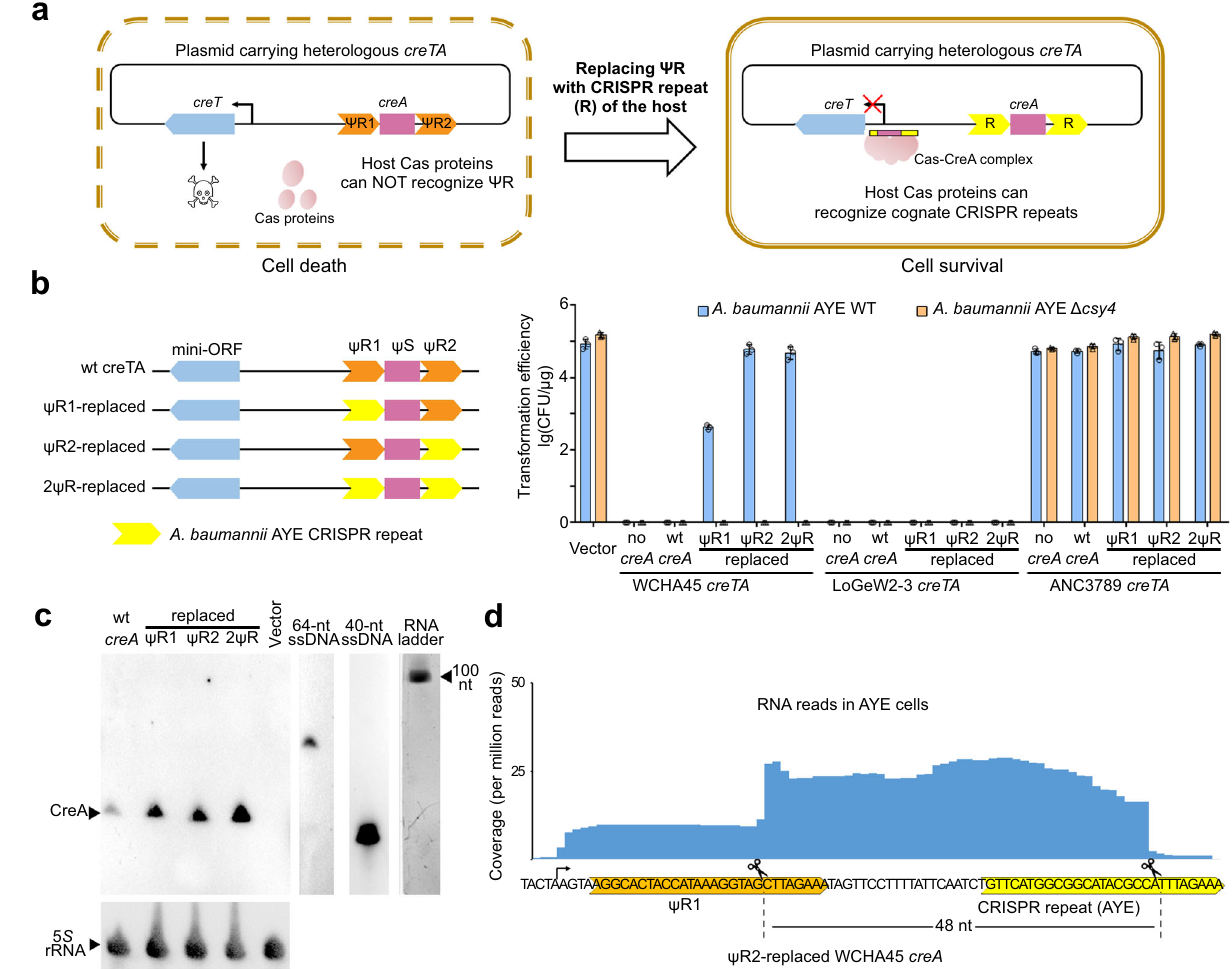
TACTAAGTAAGGCACTACCATAAAGGTAGCTTAGAAATAGTTCCTTTTATTCAATCTGTTCATGGCGGCATACGCCATTTAGAAA25 Fig.2|RepeatreplacementtorebootheterologousCreTAin A.baumannii AYE. formationunit.Dataarepresentedasmeanvalue±s.d.( n =3biologicalreplicates). c Northern blotting of CreA molecules produced from a wt or a repeat-replaced a Scheme illustrating the principle of repeat replacement. The host Cas proteins WCHA45 creA gene. Plasmids bearing only the creA gene (without creT ) were cannot be guided by a heterologous creA to repress toxin expression unless the introduced into AYE cells for this assay. All data were acquired from at least three degeneratedrepeats( Ψ R1and Ψ R2,inorange)arereplacedbythecognateCRISPR independentreplicateswithsimilarresults. d IdentifythesequenceoftheWCHA45 repeats (R, in yellow) of Cas proteins. b Transformation ef fi ciency of A. baumannii CreA RNA( Ψ R2-replaced)by small RNAsequencing. Scissors indicate the cleavage AYE cells by plasmids carrying a wild-type (wt) creTA or its derivates where one or sites of Csy4. Source data are provided as a Source Data fi both Ψ R elements were replaced by the CRISPR repeat of AYE. CFU, colony